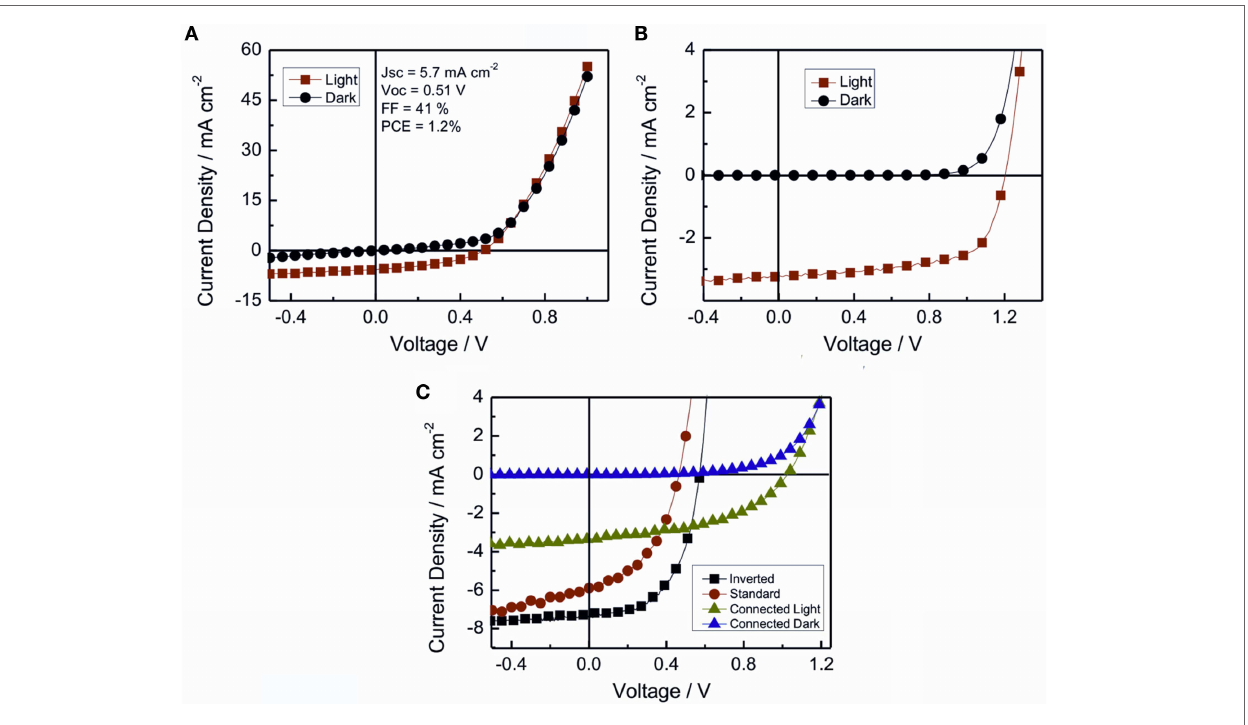
FigUre 8 | J–V curves of (a) a standard device with a Pei:PcBM electron-selective interlayer and silver top contact, (B) a standard (glass/iTO/ PeDOT:Pss/P3hT:PcBM/liF/al) and an inverted (glass/iTO/Pei/P3hT:PcBM/MoO x /ag) device connected in series by a common iTO electrode, (c) a standard device with a Pei:PcBM electron-selective interlayer and silver top electrode, and an inverted (glass/iTO/Pei/P3hT:PcBM/MoO x /ag) device connected in series with a common iTO electrode measured combined and independently